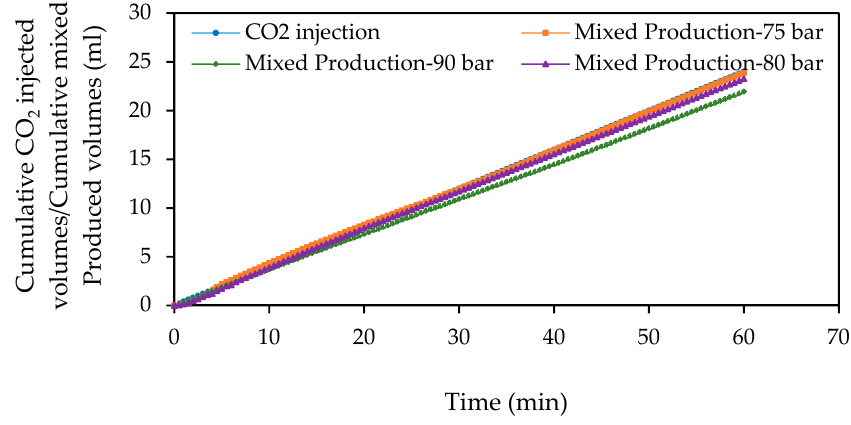
Figure 20. Effect of fluid pressure on the cumulative produced volumes of oil and CO 2 for ScCO 2 –oil displacements conducted at 33 °C and 0.4 mL/min.